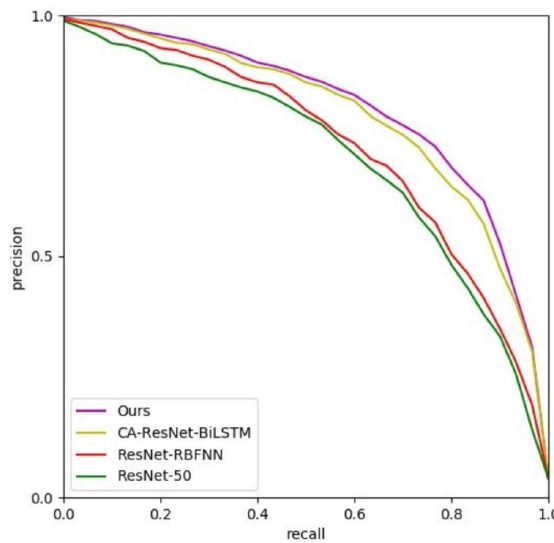
Figure 11. Average precision–recall curves on UC-Merced